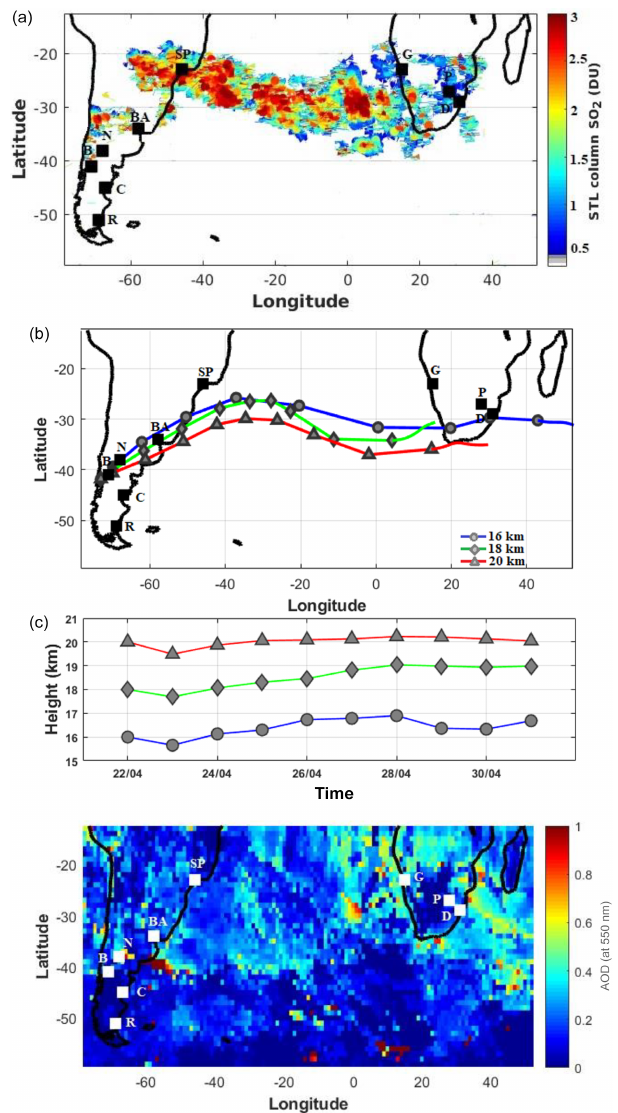
Figure 1. (a) A time-averaged map of the SO 2 column in the lower stratosphere observed by OMI during the 22 April–1 May period. (b) Forward-trajectory analysis of air masses from the HYSPLIT model starting at the Calbuco volcano coordinates at 16km (blue line with grey dots), 18km (green line with grey diamonds), and 20km (red line with grey triangles). (c) A time-averaged map of MODIS AOD (550nm) during the 22 April–1 May period. The lo- cations of the selected sites are indicated by black boxes and the site abbreviations: Bariloche (B), Neuquén (N), Buenos Aires (BA), São Paulo (SP), Comodoro (C), Rio Gallegos (R), Gobabeb (G), Durban (D), and Pretoria